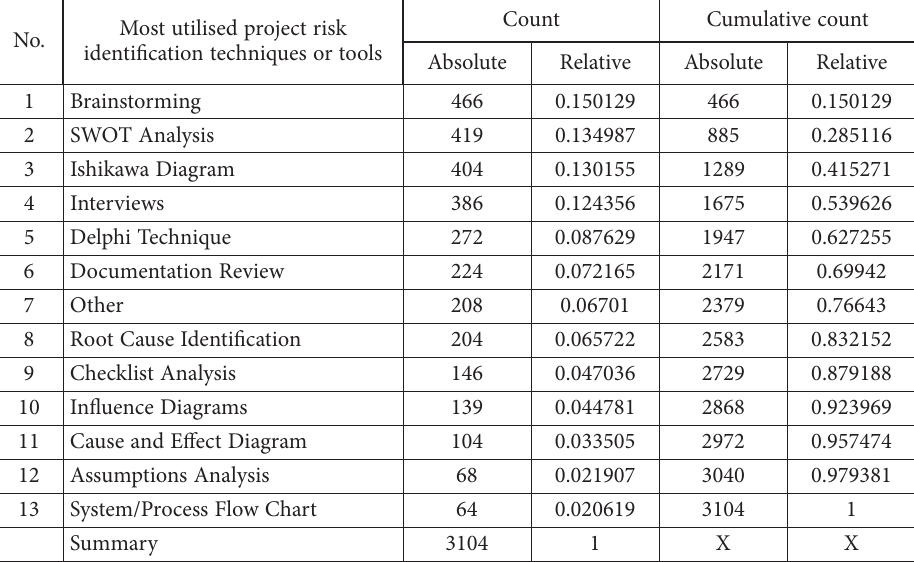
Table 2. Most utilised project risk identification techniques or tools (n = 1,143) (source: own calculations)